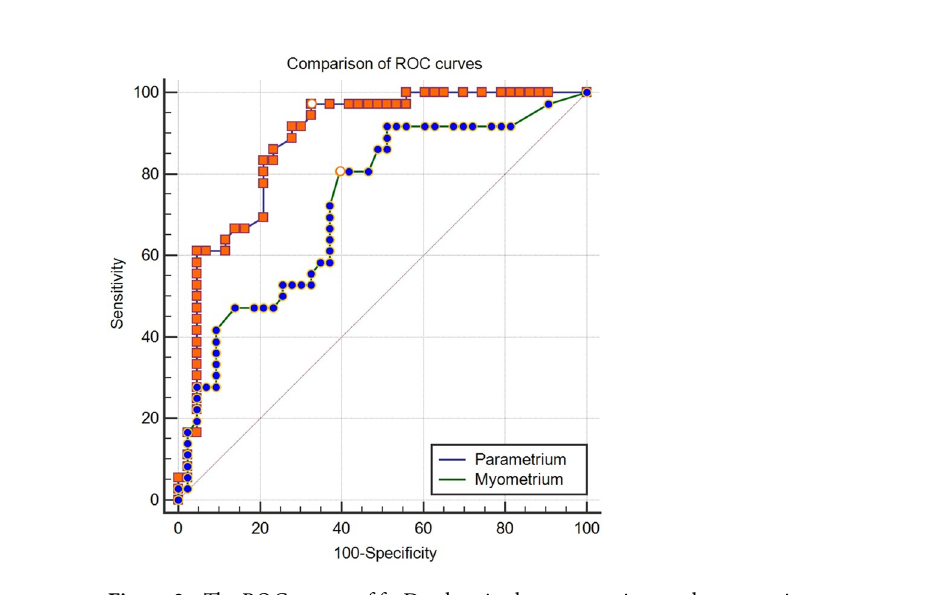
Figure 2. The ROC curves of fv-D values in the parametrium and